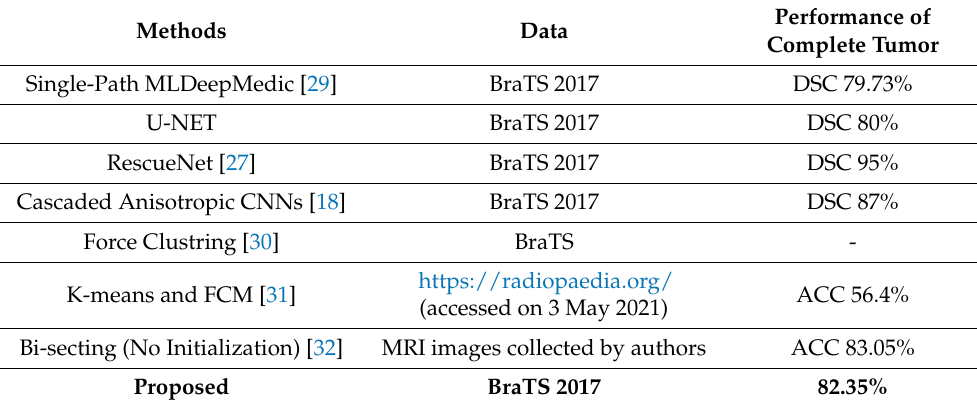
Table 6. Performance comparison between our proposed method and different CNN approaches on BraTS 2017